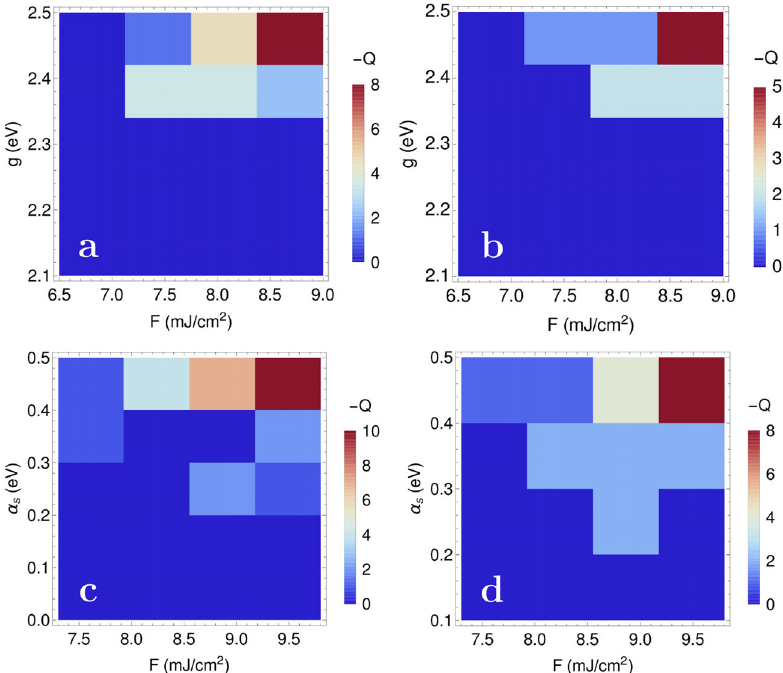
Fig. 3 Parameter dependence of skyrmion excitation. a , b Topological charge Q at t ≈ 320 fs as a function of laser fl uence F and spin – electron coupling g , for a spin – orbit coupling α s = 0.5 eV. c , d Topological charge Q at t ≈ 320 fs as a function of laser fl uence F and spin – orbit coupling α s , for a spin – electron coupling g = 2.5 eV. Panels a and c show the topological charge for a magnetic fi eld B = 7.5 meV, and panels b and d for B = 10 meV. The system is square lattice with 30 × 30 sites with d -electron spin parameters J = 50 and D = 25 meV, and s -electron hopping t s = 1 eV. The laser has a photon energy (cid:2) h ω = 0.5 eV, pulse duration τ = 30 fs, and spot size ≈ 14